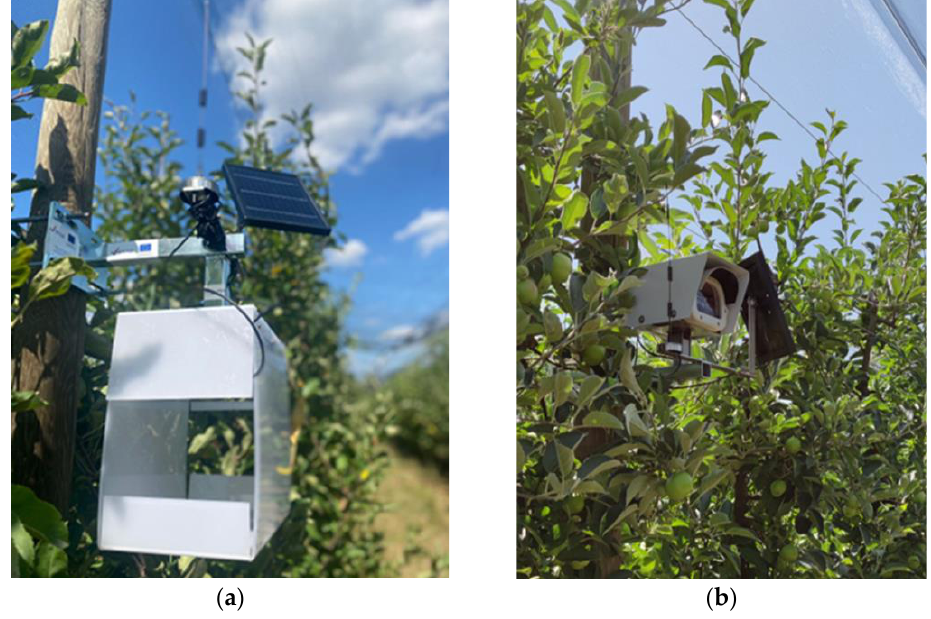
Figure 7. Pest Monitoring Device ( a ); Vegetation Monitoring Device ( b ).